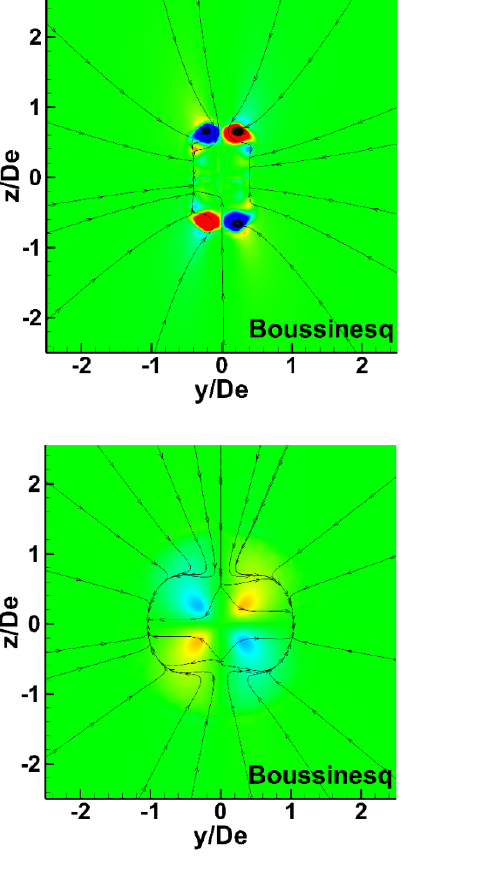
Figure 14. Streamwise vorticity contours along cross-flow planes at x/De = 1 ( top ) and x/De = 8.9 (bottom).